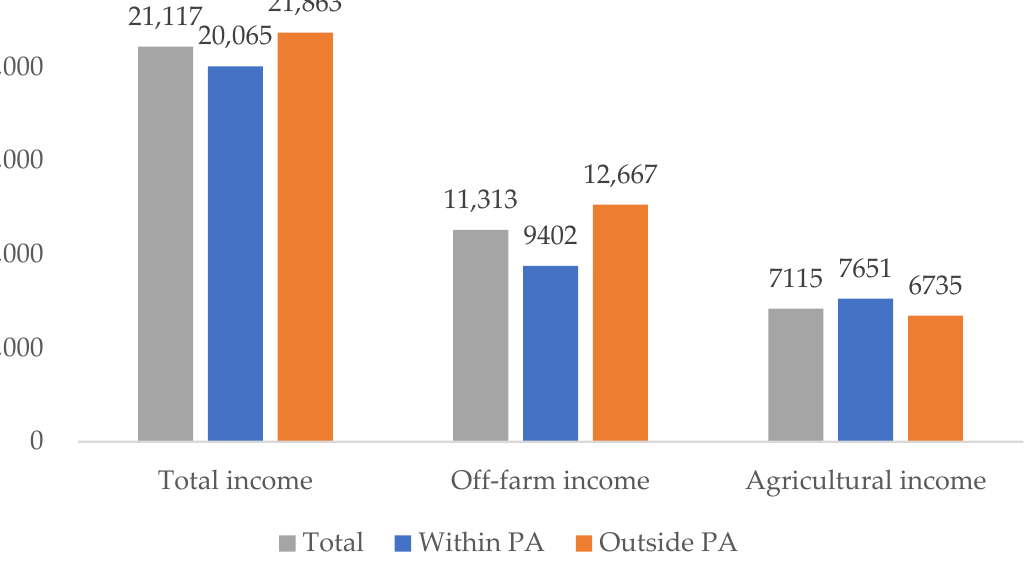
Figure 4. Different income types for households at study sites (CNY). Households who participated in skill training had obviously higher income than those who did not participate in any training (Figure 5). It can be seen that the per capita agricultural income and per capita off-farm income of the participants were 20% higher than those of non-participants. This finding indicates that skill training, as an important means to develop human capital, can play a crucial role in increasing the income of households around PAs, similarly to other regions in China